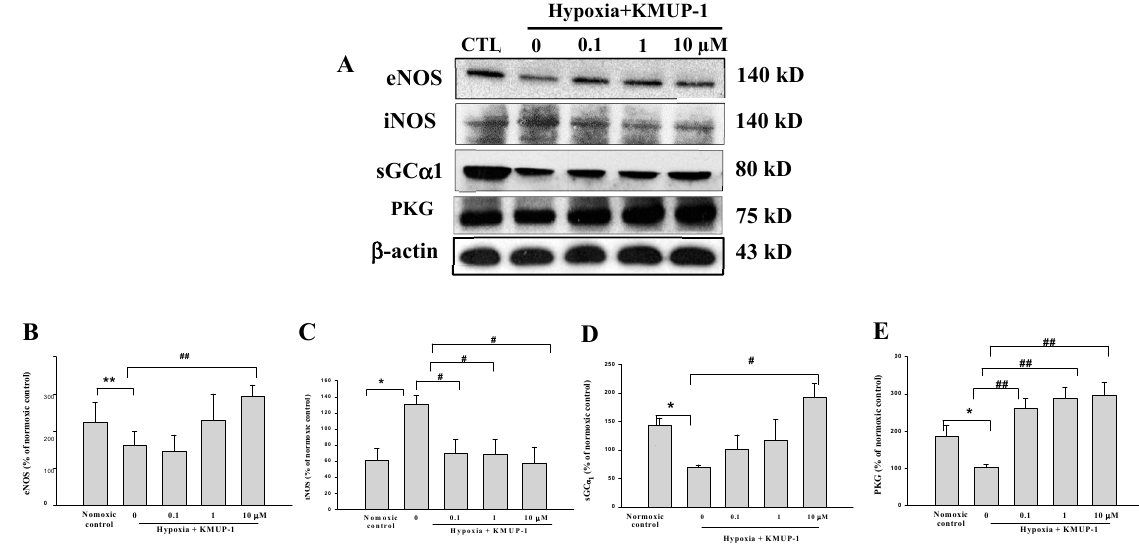
Figure 5. Effects of KMUP-1 on eNOS, iNOS, sGC α 1, and PKG protein expressions in H9c2 cardiomyoblasts induced by hypoxia. ( A ) Western blot analyses of these proteins were performed on whole protein extracts from H9c2 cardiomyoblasts during hypoxia (24 h). Quantitative analysis protein expressions ( B ) eNOS, ( C ) iNOS ( D ) sGC α 1, and ( E ) PKG. Results were presented as mean ± SEM from three independent experiments. * p < 0.05 vs. normoxic control, # p < 0.05 vs. hypoxic control ## p < 0.01 vs. hypoxic control.